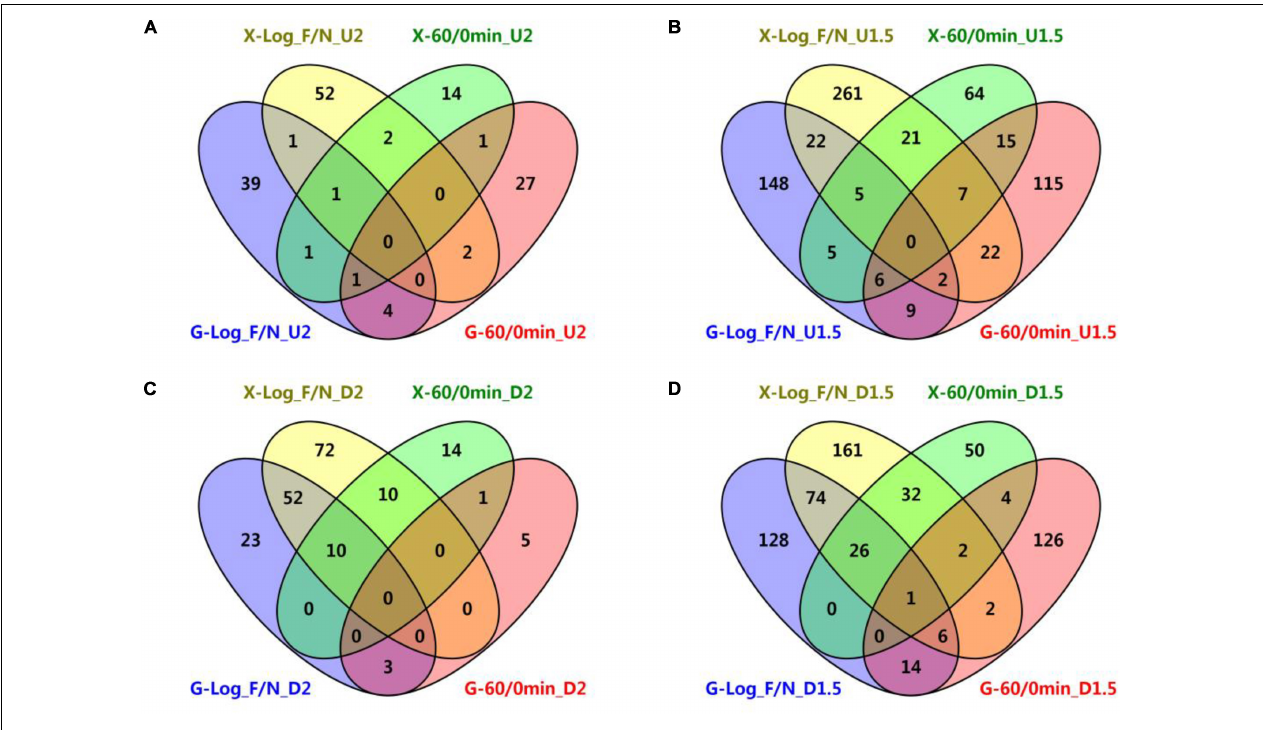
FIGURE 3 | Venn diagrams of common genetic features shared by short-term furfural shock and long-term furfural stress responses in RMG8 and RMX8. (A) The furfural up-regulated features with at least twofold increase; (B) the furfural up-regulated features with at least 1.5-fold increase; (C) the furfural down-regulated features with at least twofold decrease; (D) the furfural down-regulated features with at least 1.5-fold decrease. X-Log_F/N, G-Log_F/N: genetic features up-regulated for long-term furfural stress in log phase compared to control without furfural supplementation in RMX8 or RMG8 medium respectively; X-60/0min, G-60/0min: genetic features up-regulated for short-term 60 min post furfural shock compared to control before furfural supplementation in RMX8 or RMG8 respectively; U2, U1.5, D2, D1.5 represent significantly up-regulated 2 and 1.5-folds as well as down-regulated 2 and 1.5-folds